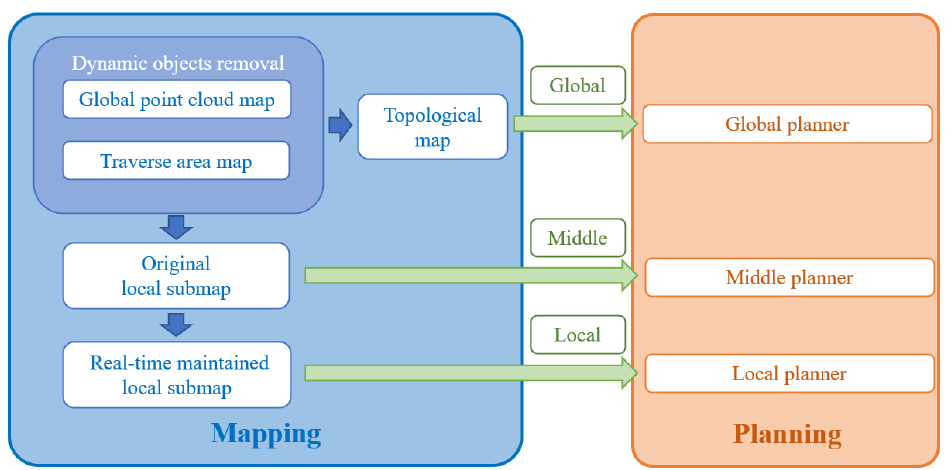
Figure 3. System framework (our navigation system includes mapping and planning modules, forming a three-level